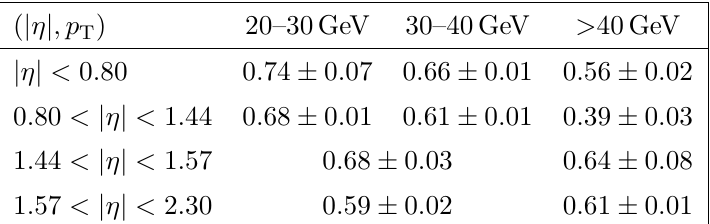
Table 8. Transfer factor R determined from the W+jets control sample according to eq. (5.1), as a function of p T and (cid:17) of the (cid:28) h candidate. The uncertainties are statistical